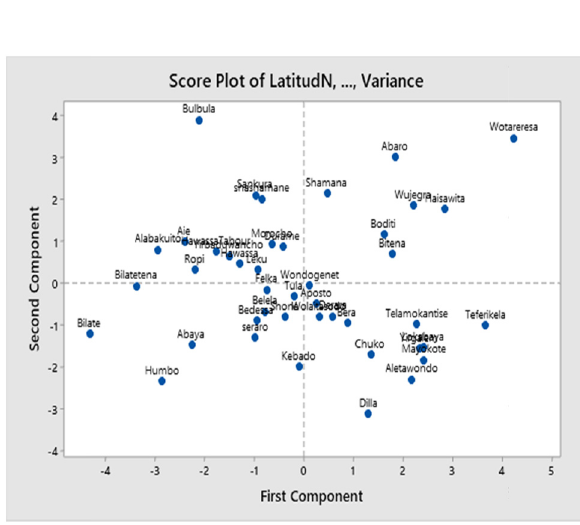
Figure 3: Score plot of observations for PC1 and PC2.